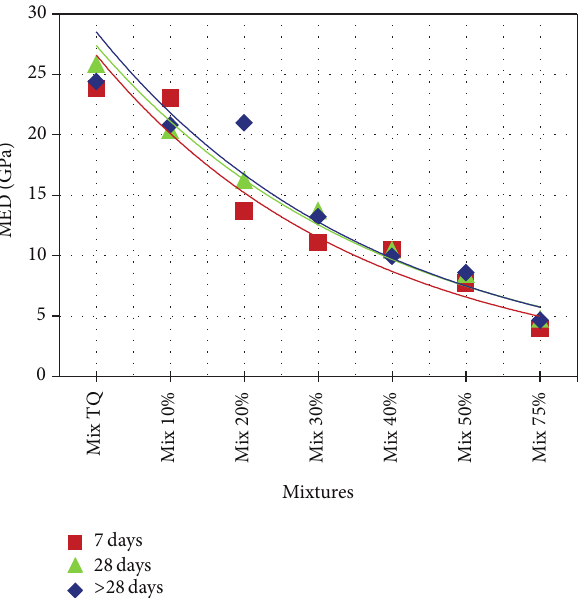
Figure 8: MED of rubber cement composites on days 7, 28, and > 28.